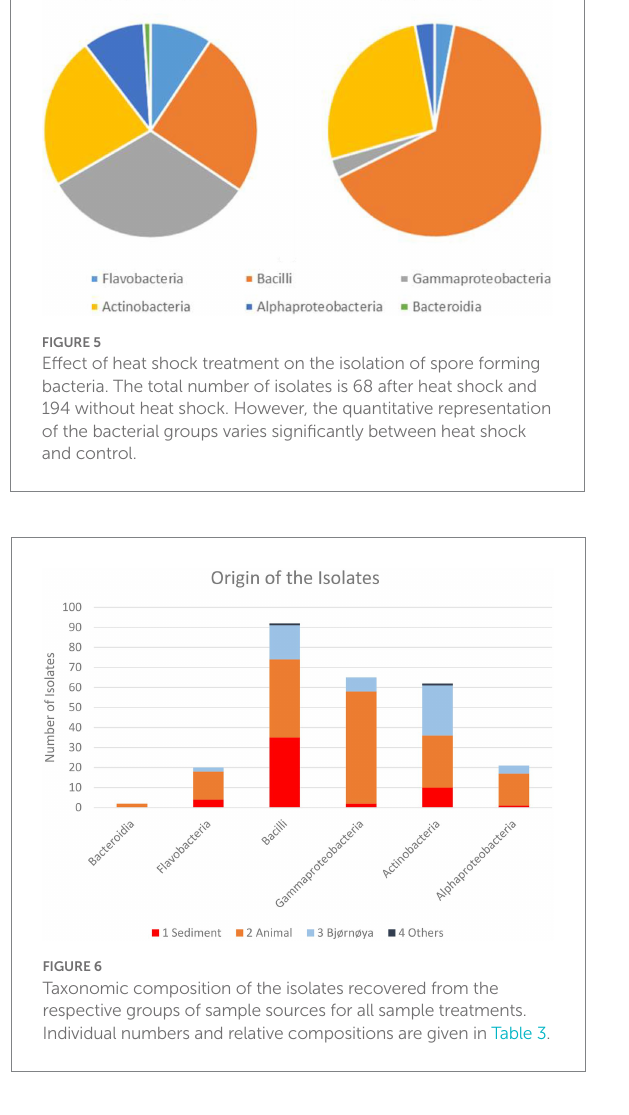
TABLE 3 Taxonomic composition of the isolates grouped among the four groups of sample types, given are the numbers of respective isolates and relative numbers of isolates for the respective media in brackets, a visualization is given in Figure 6. 1 Sediment 2 Animal 3 Bjørnøya